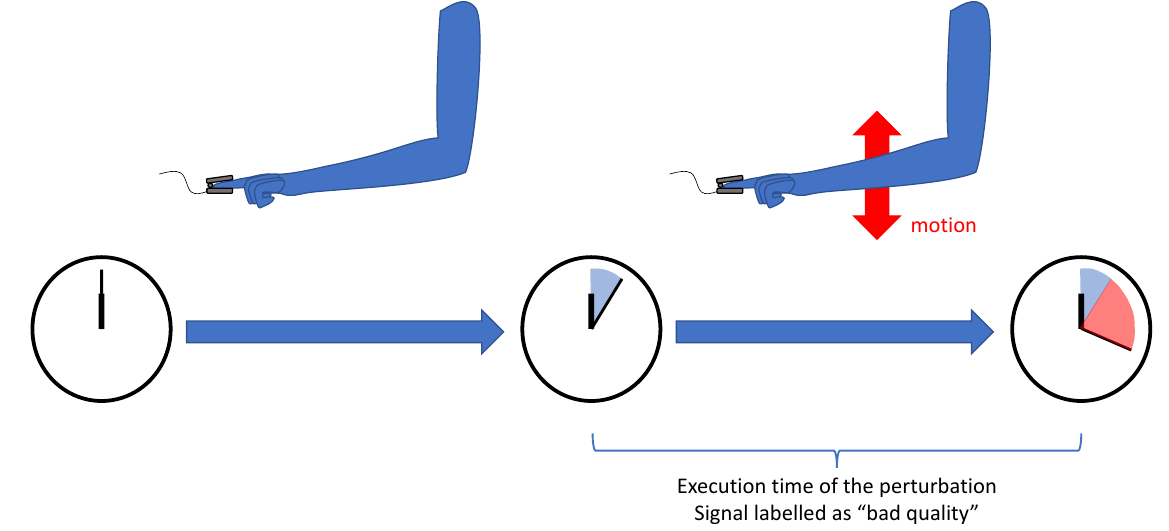
Figure 4. Example of annotation done during a controlled experiment. Here, a patient is wearing a PPG sensor and is asked to not move during a given period. Then, at a specific time, the patient is asked to artificially create a perturbation (here, a motion artifact with up–down movement). The signal recorded during this period of perturbation is automatically annotated as